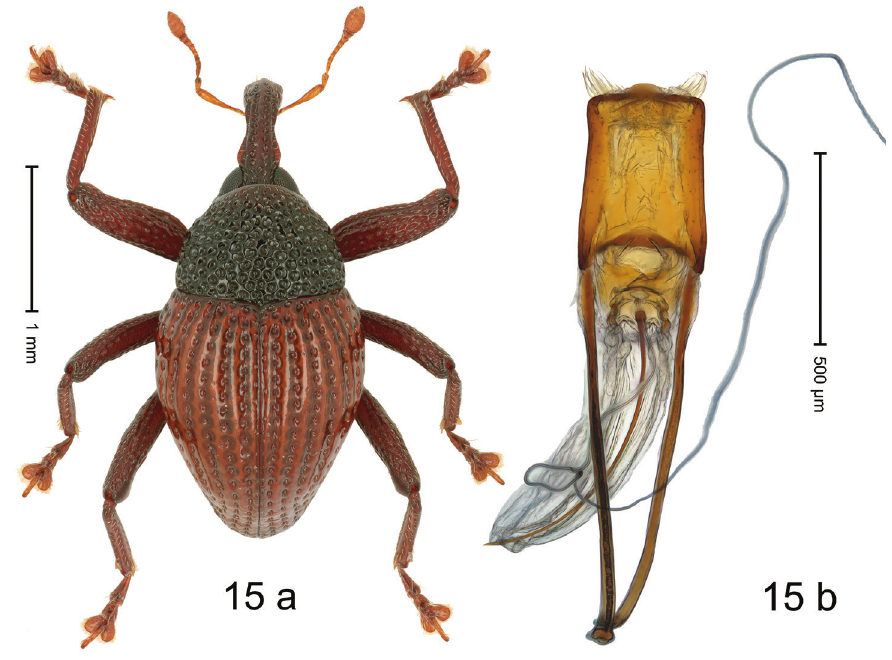
Figure 15. Trigonopterus paramoduai sp. nov., holotype a habitus b penis.